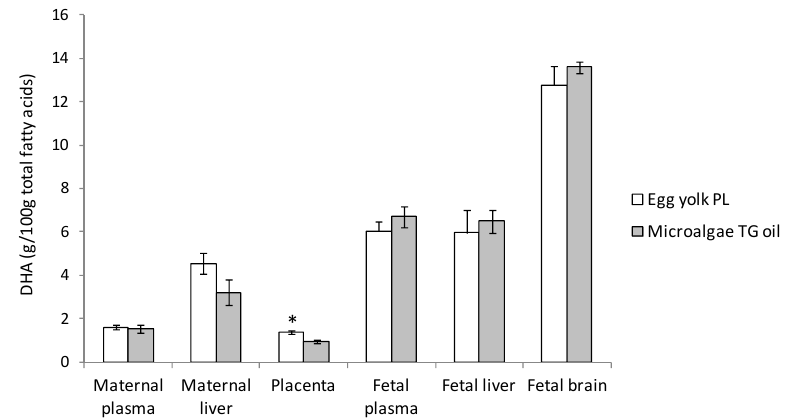
Figure 3. Docosahexaenoic acid (DHA) percentage at delivery in maternal and fetal tissues after maternal DHA supplementation (0.8% of total fatty acids) as phospholipid (PL) from egg yolk or triglycerides (TG) from microalgae oil during the last third of gestation in sows (40 d). Values are means ± SEM ( n = 6/group). * Indicates significant differences between PL and TG groups of the same tissue ( p < 0.05). Data from Gázquez et al. 2017 [113].